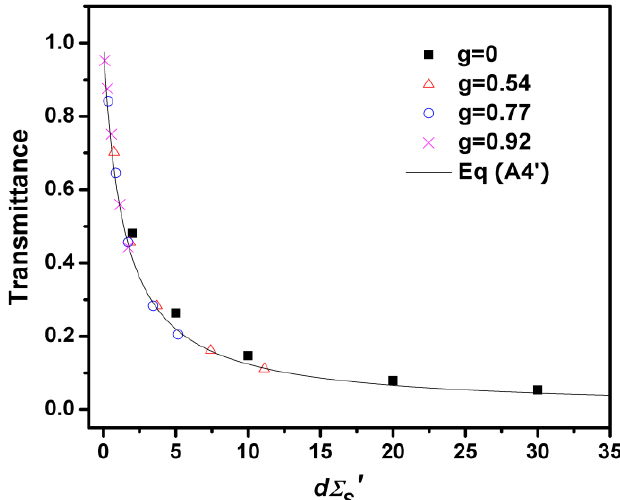
Figure 2. Comparison of transmittance predicted by Equation (A4 ′ ) [12] with results of Monte Carlo